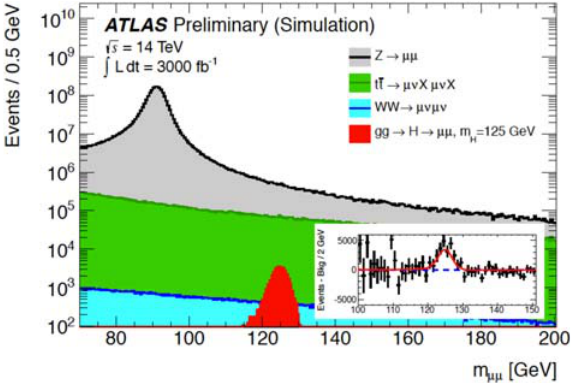
Figure 6. Simulated H → μμ signal predicted to be observed with a 6 σ signi fi cance over backgrounds with 3000 fb − 1